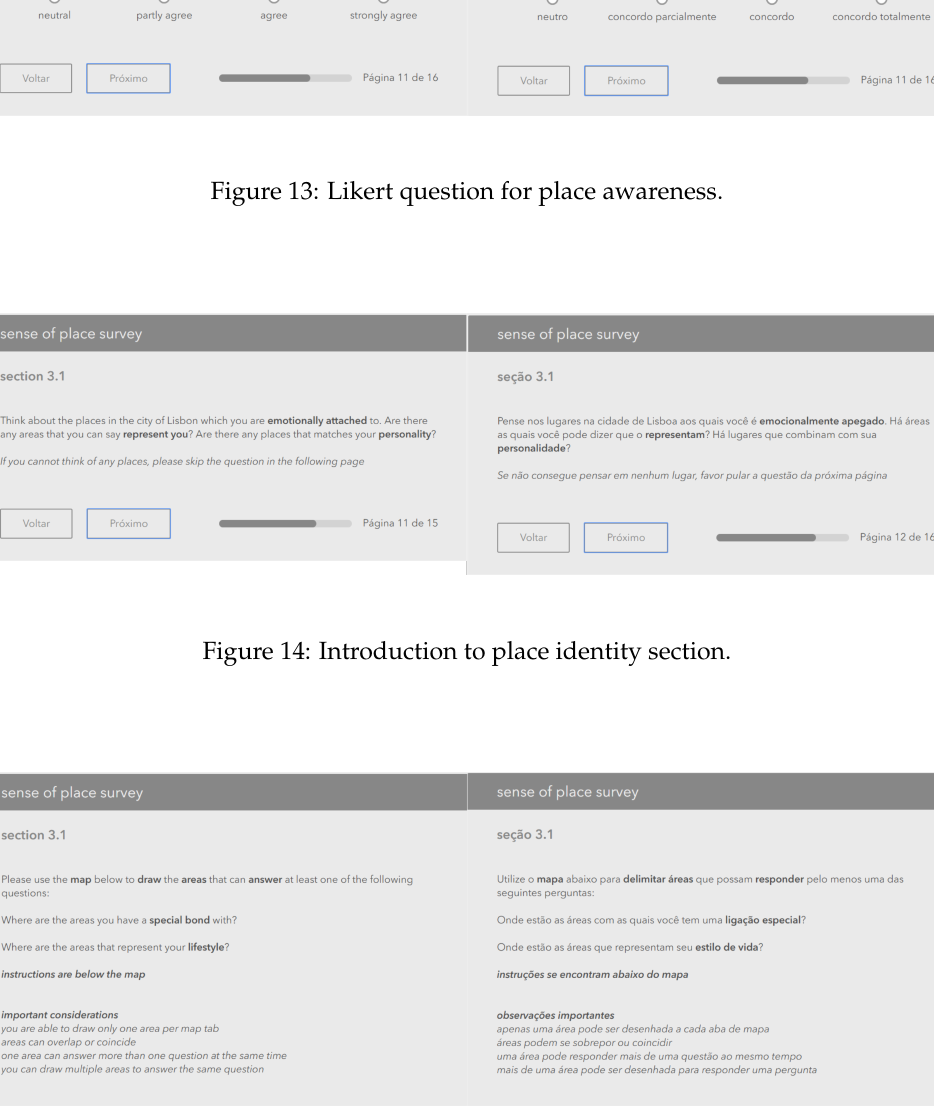
JOSIS, Number 23 (2021), pp.